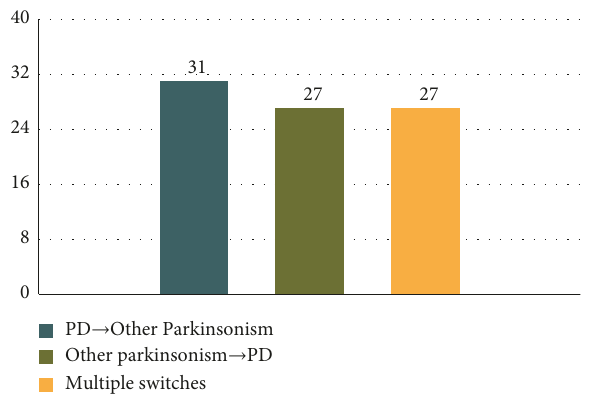
Figure 2: Direction of diagnostic switches (N �